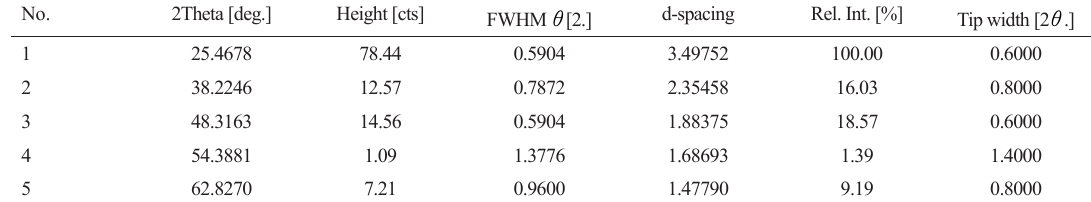
nanoparticles. 2